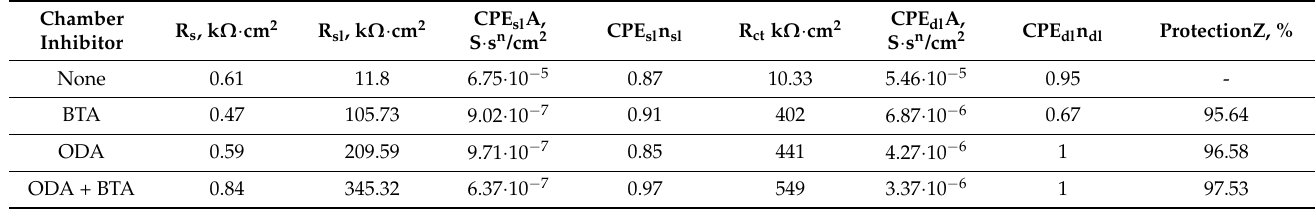
Table 5. Impedance parameters. T CT = 120 ◦ C, τ CT = 1